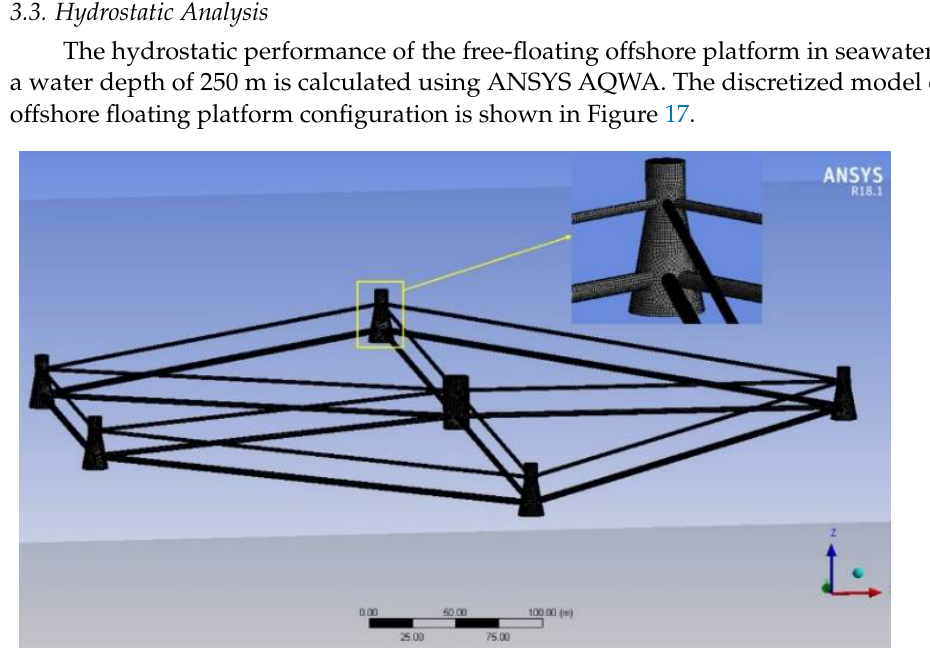
Figure 17. Discretized model of the floating platform.